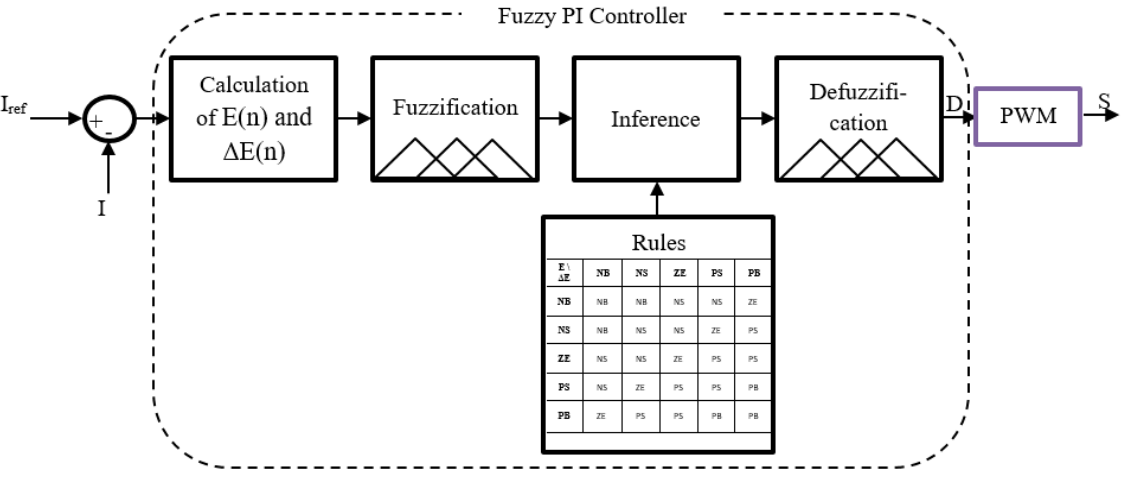
Figure 10. Block diagram of FPIC.